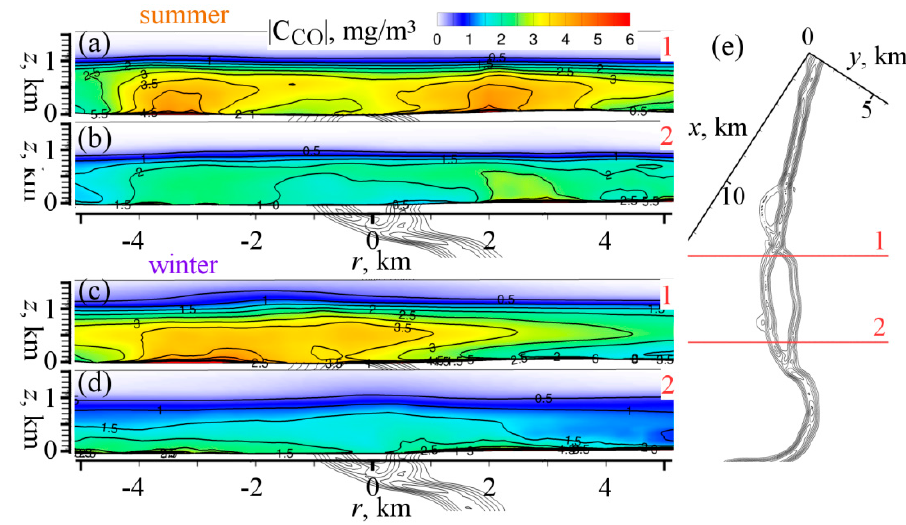
Figure 6. Daily-averaged CO concentration fields in vertical cross-sections. ( a , b ) Summer case; ( c , d ) Winter case; ( e ) The cross-sections positions. Atmosphere 2019 , 10 , x FOR PEER REVIEW